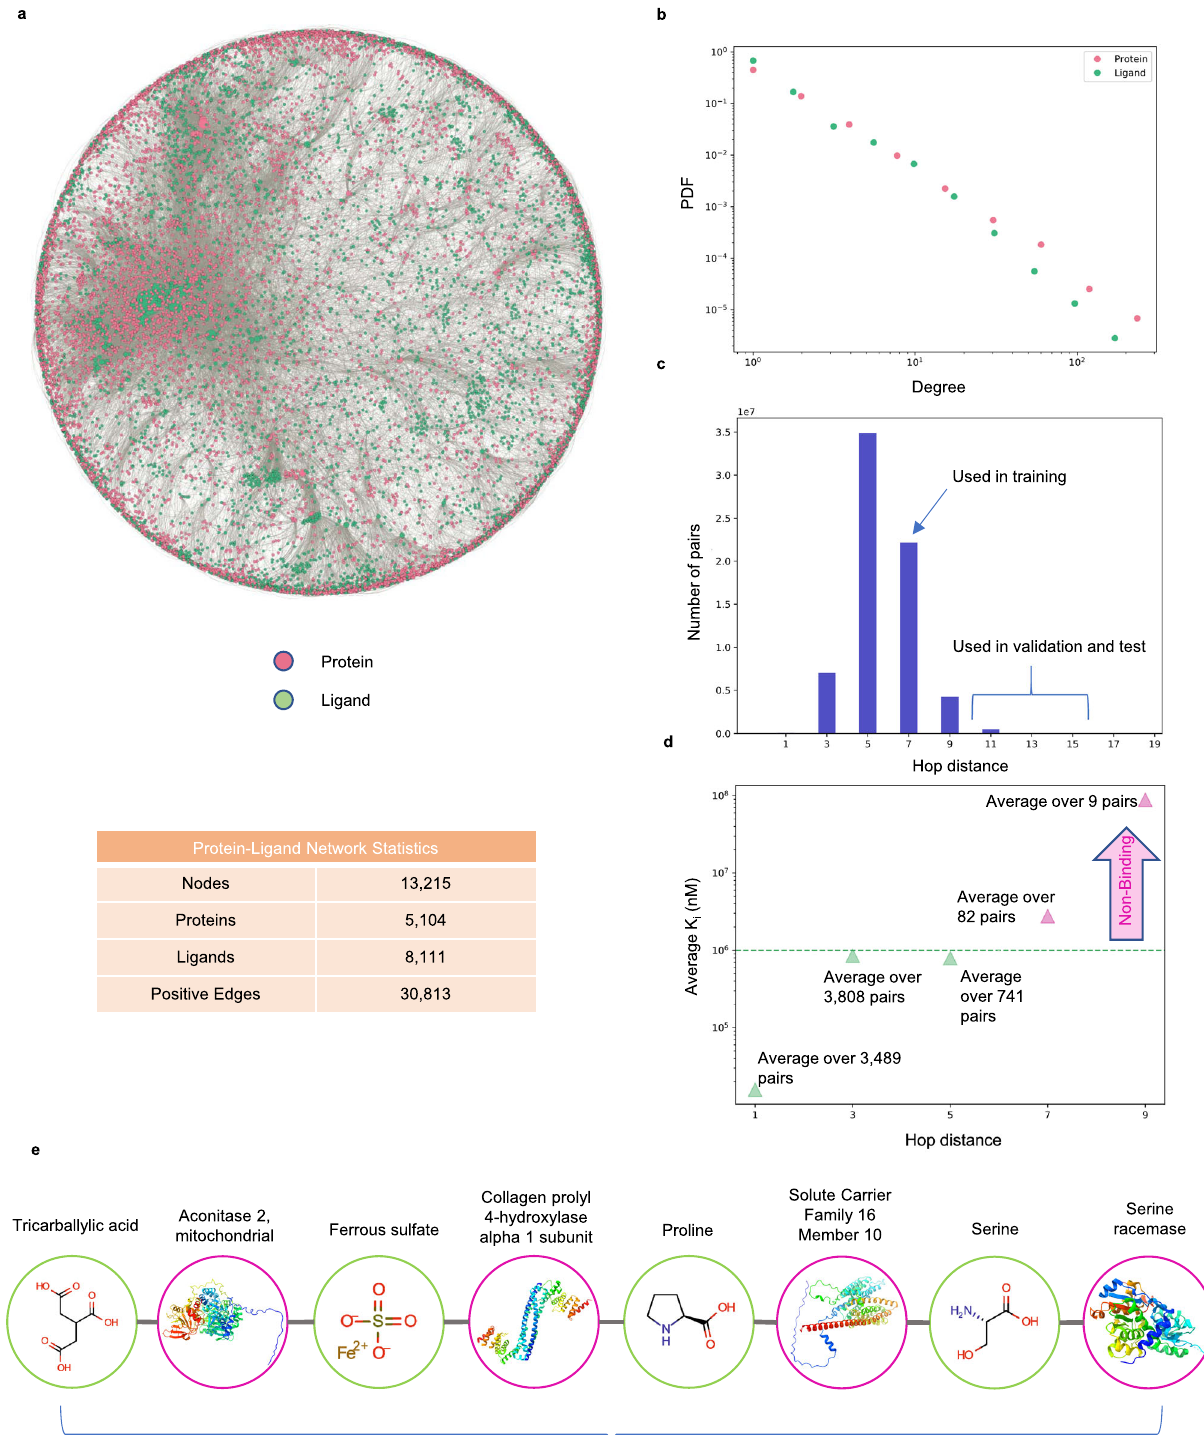
Fig. 5 | Network-Derived Negatives. a Protein-ligand bipartite network con- sisting of only binding (positive) annotations for drugs and natural com- pounds (green) to proteins (pink). b Degree distributions of ligands and proteins are fat-tailed in nature. c Shortest path length distribution capturing all possible protein-ligand pairs. We use protein-ligand pairs with shortest path distance of 7 for training, while absolute negatives obtained from Bin- dingDB and pairs with shortest path distances ≥ 11 are used for validation and